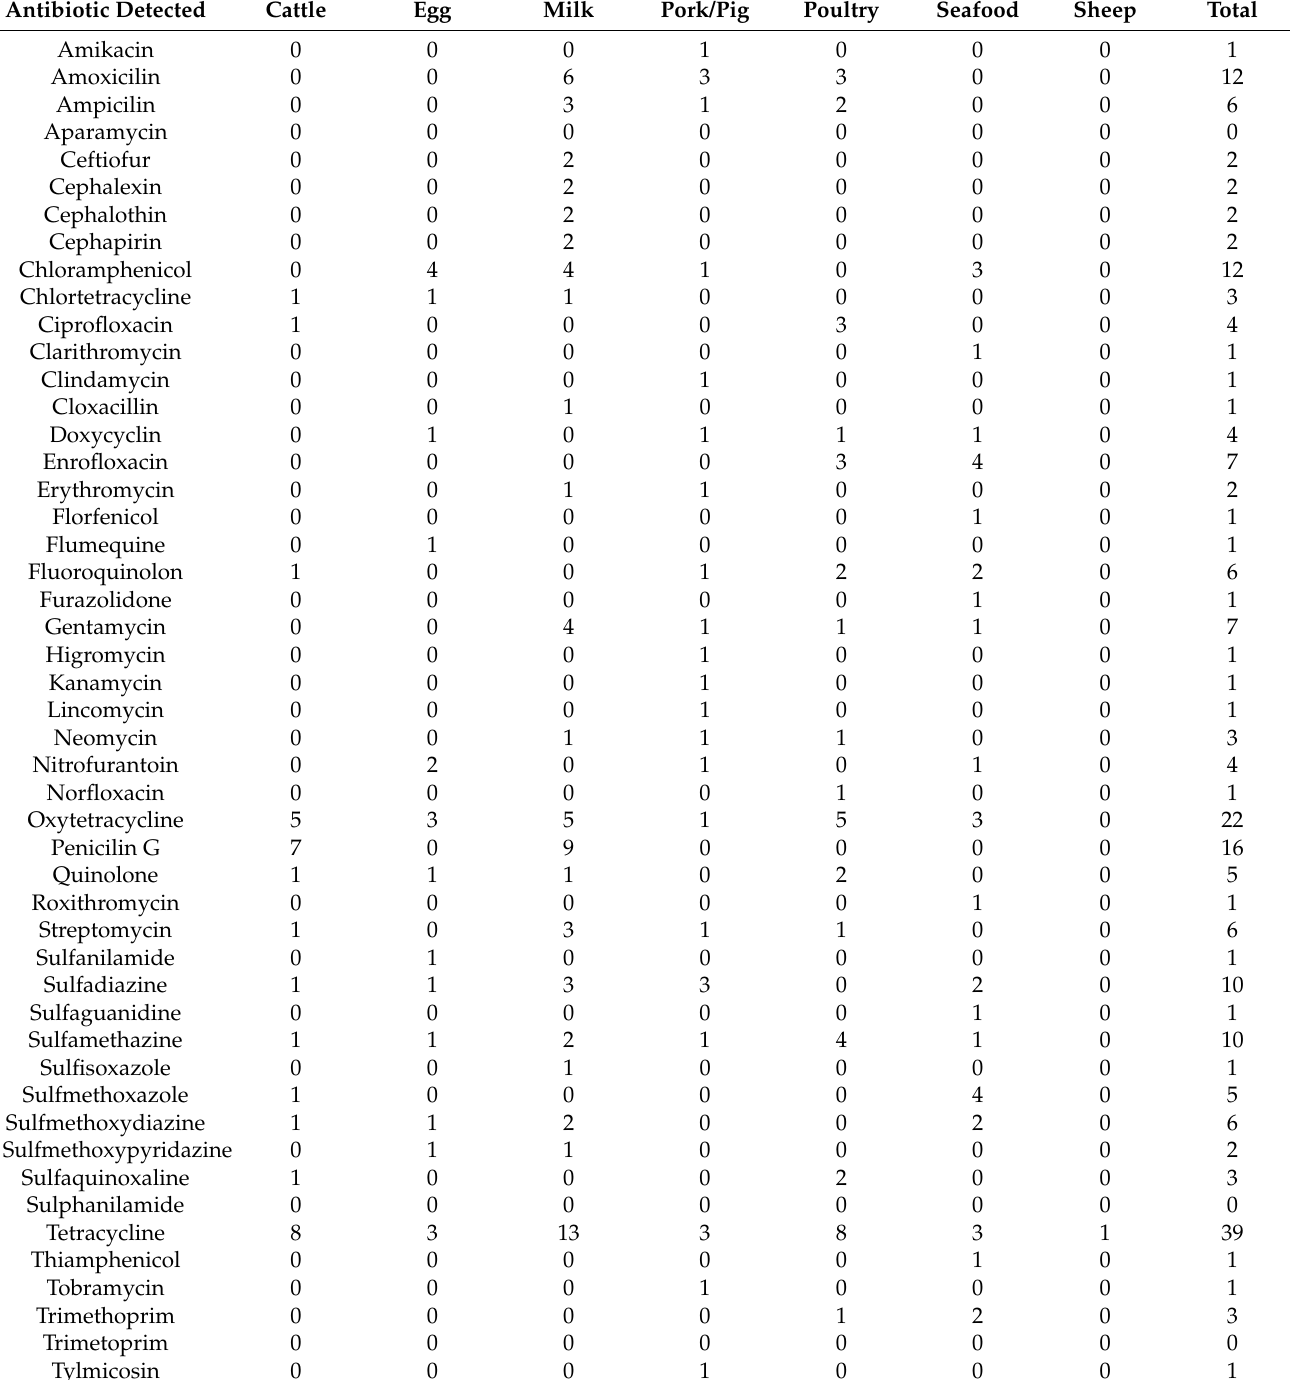
Table 3. Antimicrobial residues found in different animal